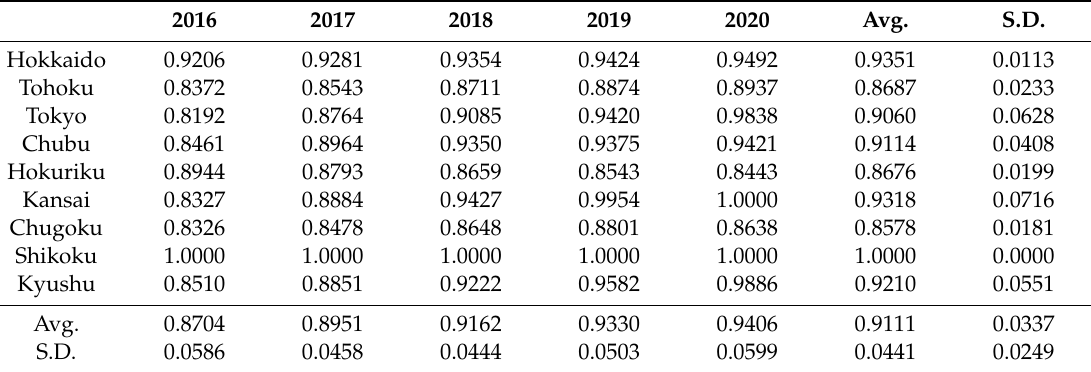
Table 8. Unified E ffi ciency of Electric Power Companies (2016–2020).